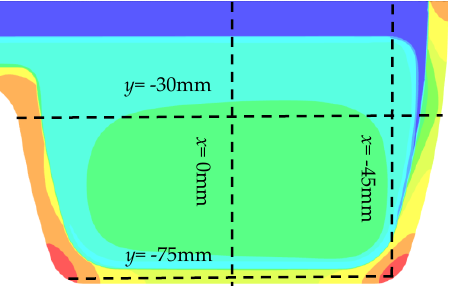
Figure 16. Schematic of the position of different cross sections. Figure 17 shows the variation of temperature with axial distance y on given x axis section at different H/D at 100 kW and 500 kW beam power. It can be seen that when beam power up to 100 kW, the temperature distribution of liquid hydrogen ( y = 0~−10.5 mm) located in inlet pipe and its adjacent area is similar at all conditions, with a change trend but not distinct. Then, with the increase of radial distance, the temperature of liquid hy- drogen in container cavity increased significantly. At the same time, due to the existence of the central recirculation zone, the temperature on the cross section of x = 0 mm was